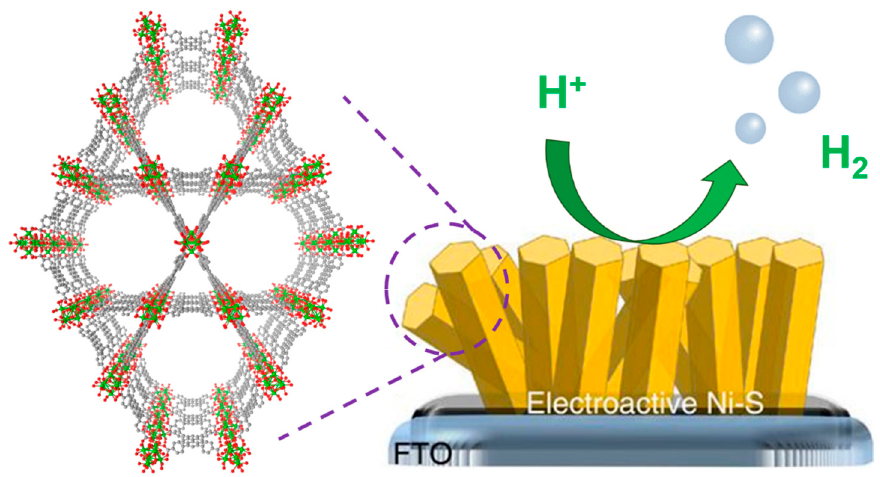
Figure 5. The NU-1000 thin film electrodeposited with a layer of nickel sulfide for electrocatalytic hydrogen evolution [83]. Lime green: Zr; red: O; grey: C. Hydrogen atoms are not shown for clarity.